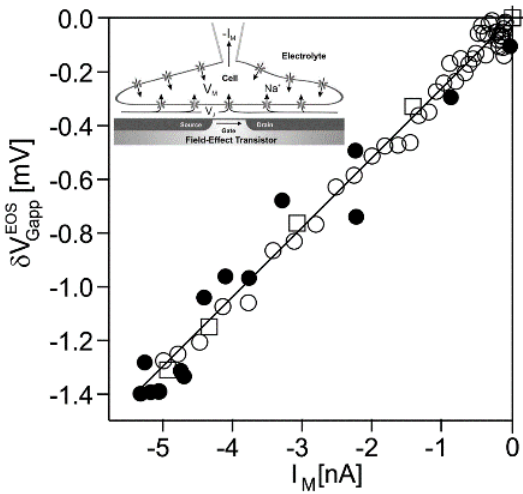
Figure 4. Transistor recording of the sodium channel Na v 1.4 in a HEK293 cell at constant intracellular voltage (by permission [32]). The apparent change of the gate voltage δ V EOS is plotted versus the membrane current I M upon a depolarization from – 90 mV to – 20 mV . (Scheme: cell with whole-cell patch-pipette). The white squares refer to the activation phase and the white circles to the inactivation phase. In addition, the minima of the voltage and of the current transients are plotted for 15 different depolarizations (black dots). The data are fitted by the relation δ V EOS Gapp .